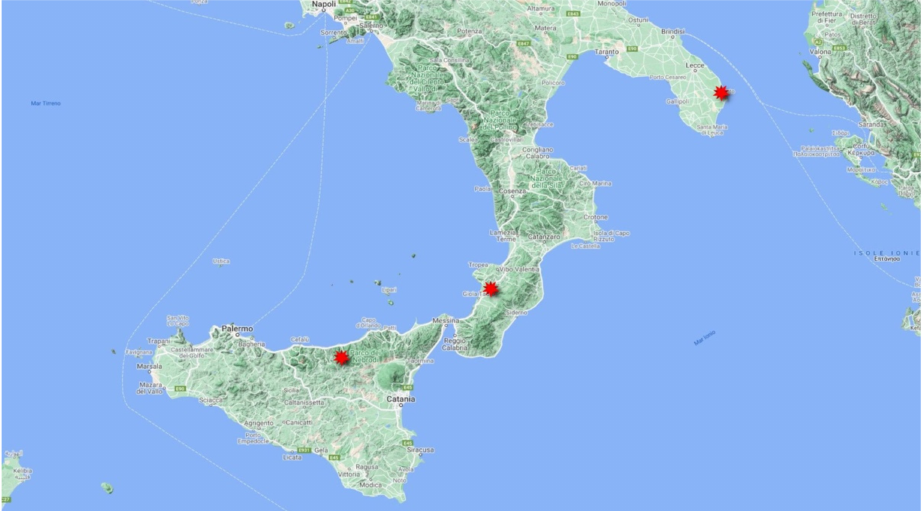
Figure 3. Current distribution of Thelypteris palustris in southern Italy.